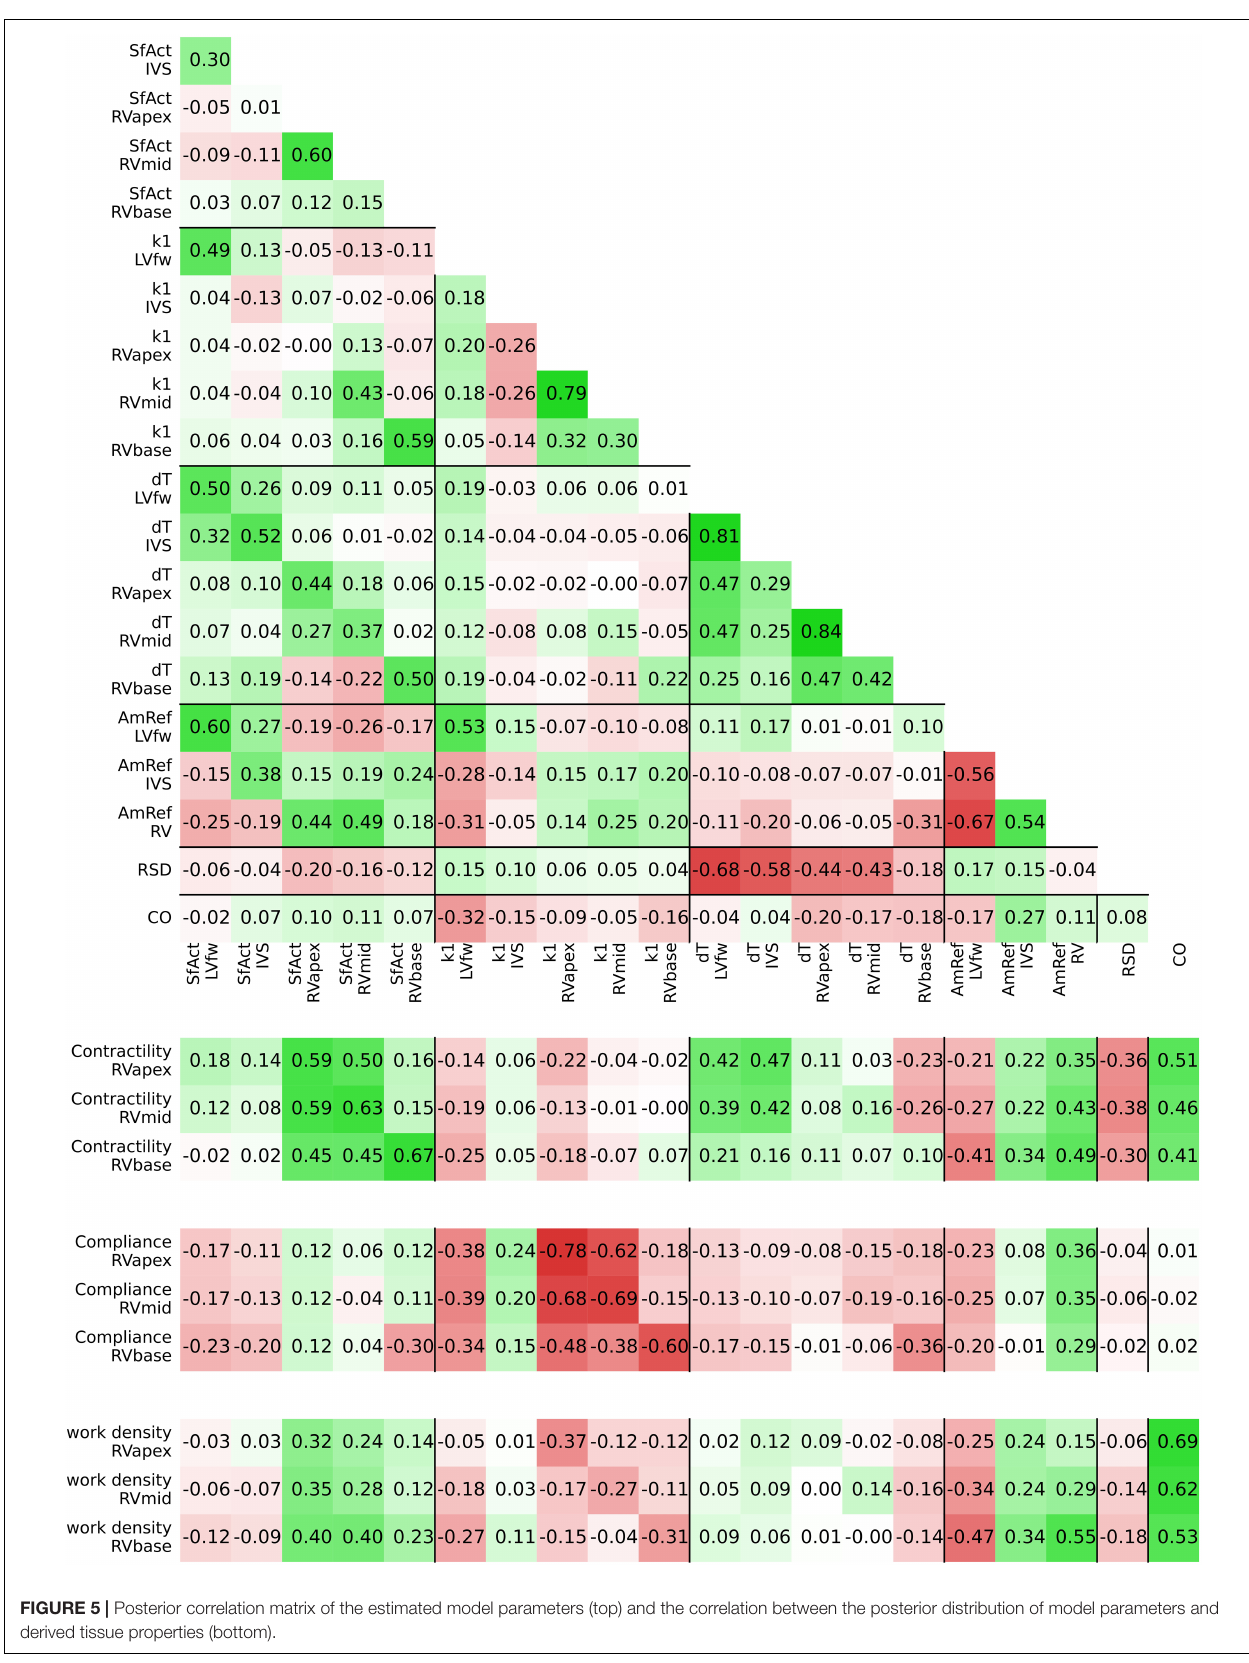
Frontiers in Physiology |